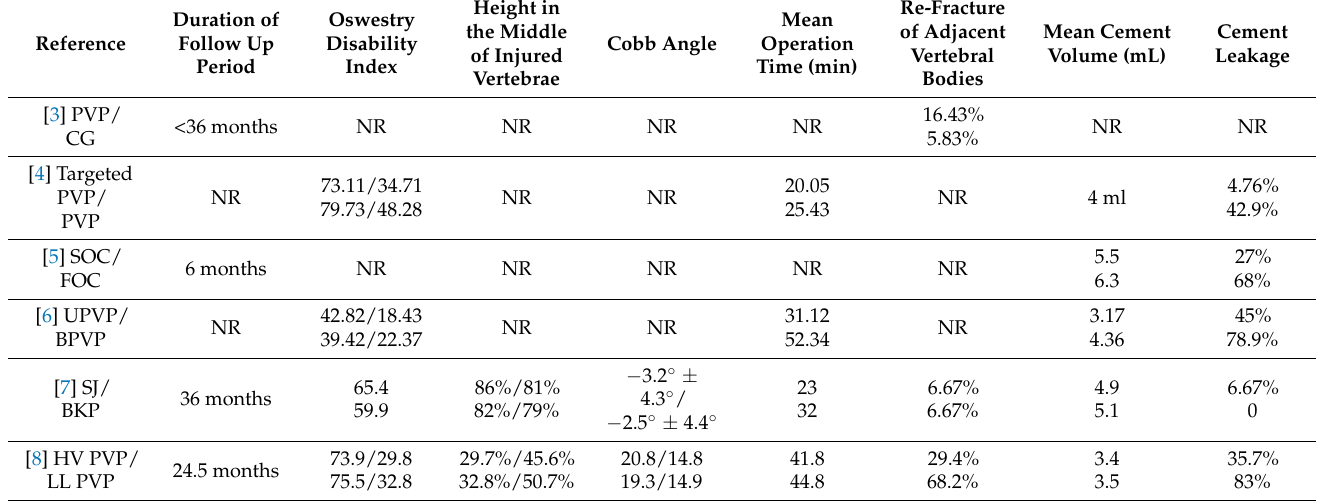
Table 3. Efficacy of treatment methods analyzed in the studies included in the